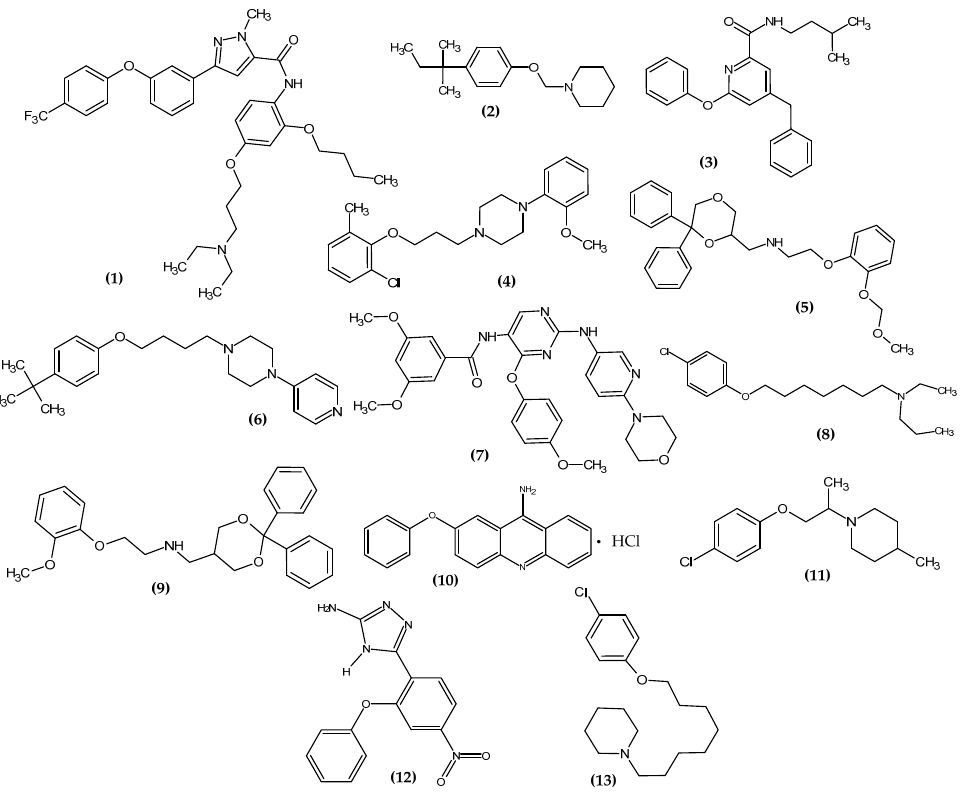
Figure 12. The novel potential agents for a neurological disorder bearing a phenoxy group.